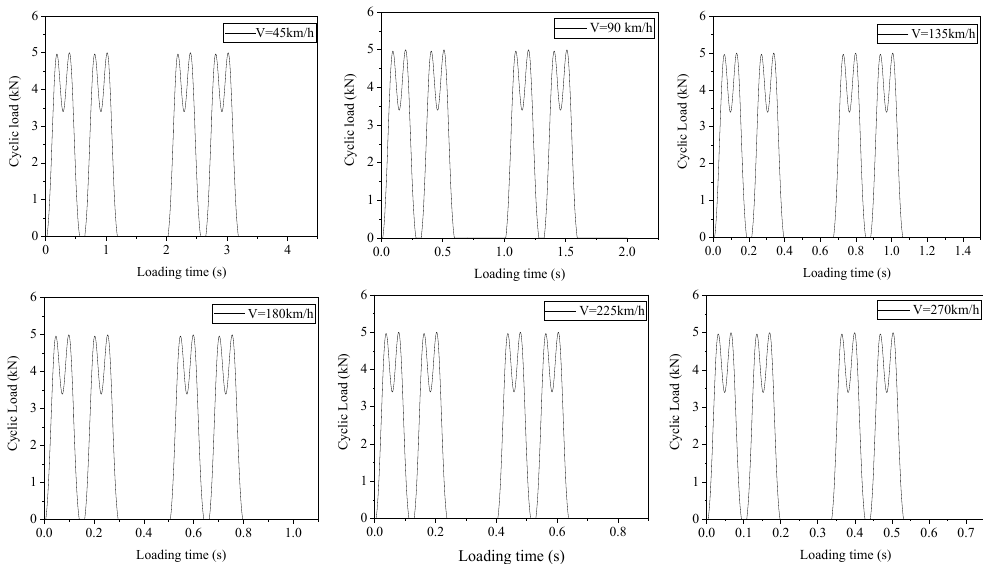
Figure 5. Actuator loading time–history curves at a reduced scale for different train speeds. A dynamic loading hydraulic servo control and digital data acquisition system (com-